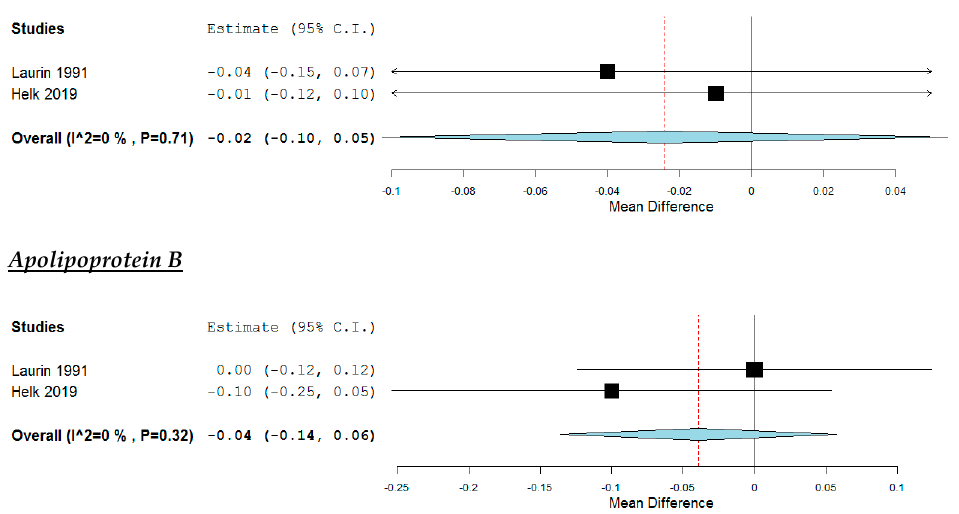
Figure 6. E ff ect of increased intake of soy protein compared with control Figure 6. Effect of increased intake of soy protein compared with control group.